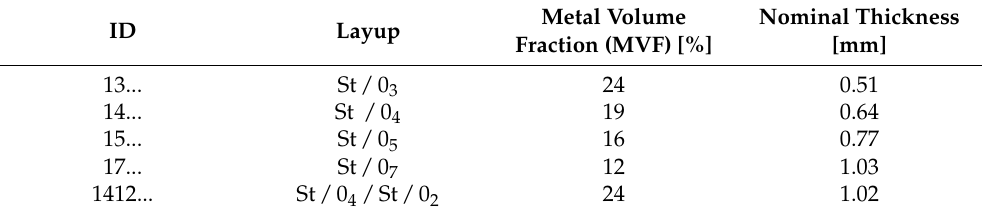
Table 7. Layup variations investigated in this work and resulting metal volume fractions (MVF) and nominal laminate thicknesses. Layups with ID 14 and ID17 are chosen for the subsequent